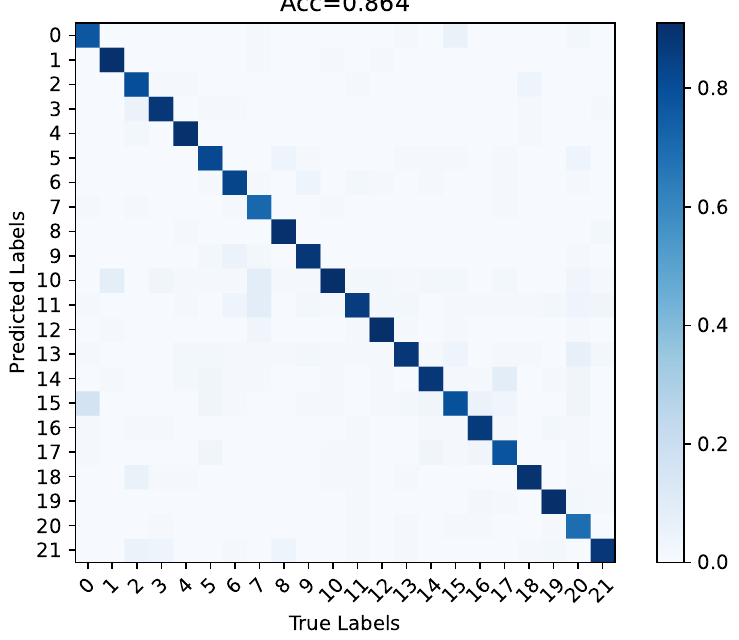
Figure 16. On TDSs-22, the classification confusion matrix of